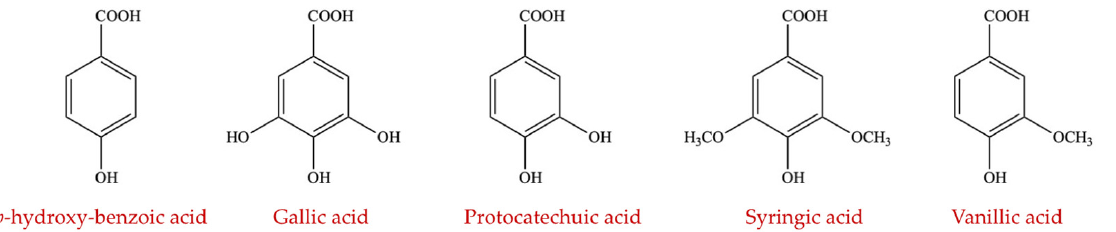
Figure 12. Chemical structures of hydroxybenzoic acids ( p -hydroxybenzoic acid, gallic acid, protocatechuic acid, syringic acid, and vanillic acid) (self-generated).